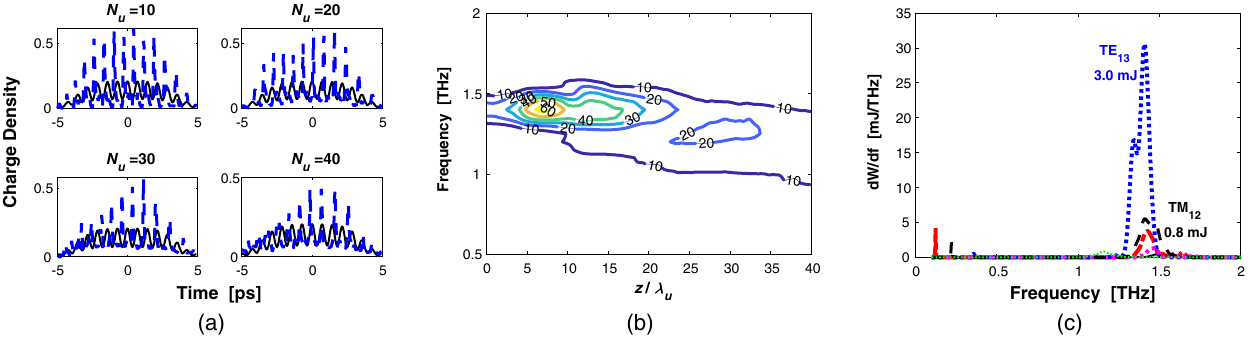
FIG. 10. Bunch with a charge of 5 nC and ten periods of half modulation at a frequency of 1.4 THz and smoothed edges in NMI regime (over-resonance guiding field of 75 kG): (a) charge density after 10 to 40 undulator periods, (b) contours of the bunching factor, and (c) radiation spectrum after 40 undulator